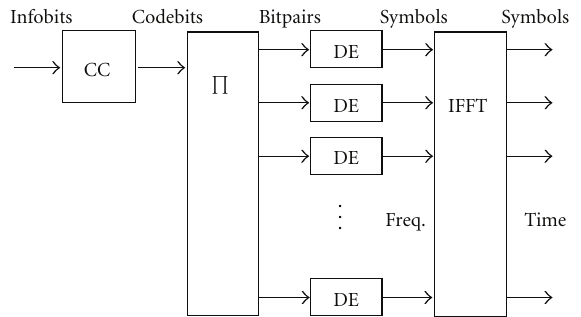
Figure 1: DAB convolutional encoder, interleaver, di ff erential encoders, and multicarrier modulator with an inverse fast Fourier transform (IFFT).